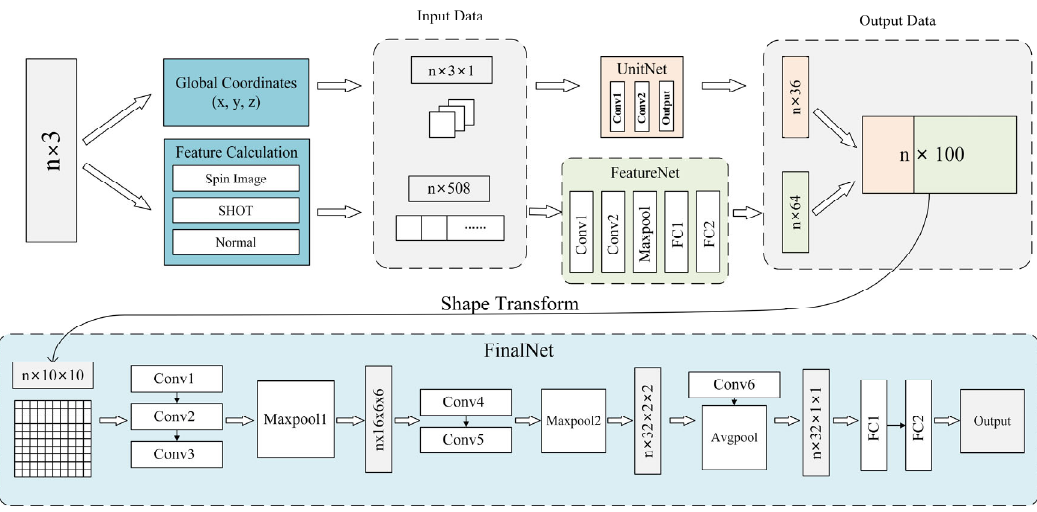
Figure 1. Network resolution.